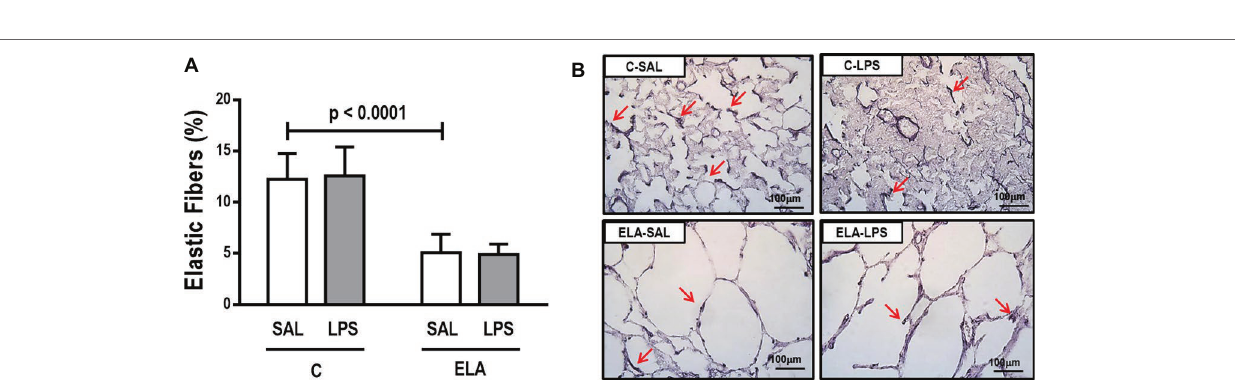
FIGURE 6 | (A) Elastic fiber content in alveolar septa and (B) representative photomicrographs of the lung parenchyma stained with Weigert’s resorcin fuchsin method with oxidation (elastic fibers). Red arrows: elastic fibers are stained in black. C, control; ELA, animals treated with intratracheal instillations of elastase; SAL, saline; LPS, E. coli lipopolysaccharide. Values are mean ± SD of six animals in each